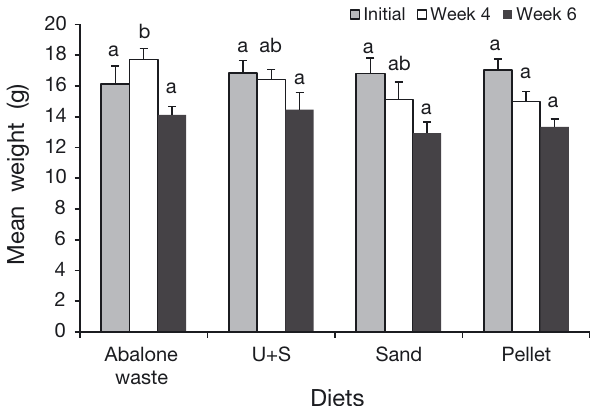
Fig. 7. Mean (+SE) weight of Neostichopus grammatus fed 4 experimental diets over a period of 6 wk (n = 20). Differ- ent letters above each bar indicate a significant difference between diet treatments for each time period (Tukey, p < 0.05). U+S: Ulva lacinulata mixed with